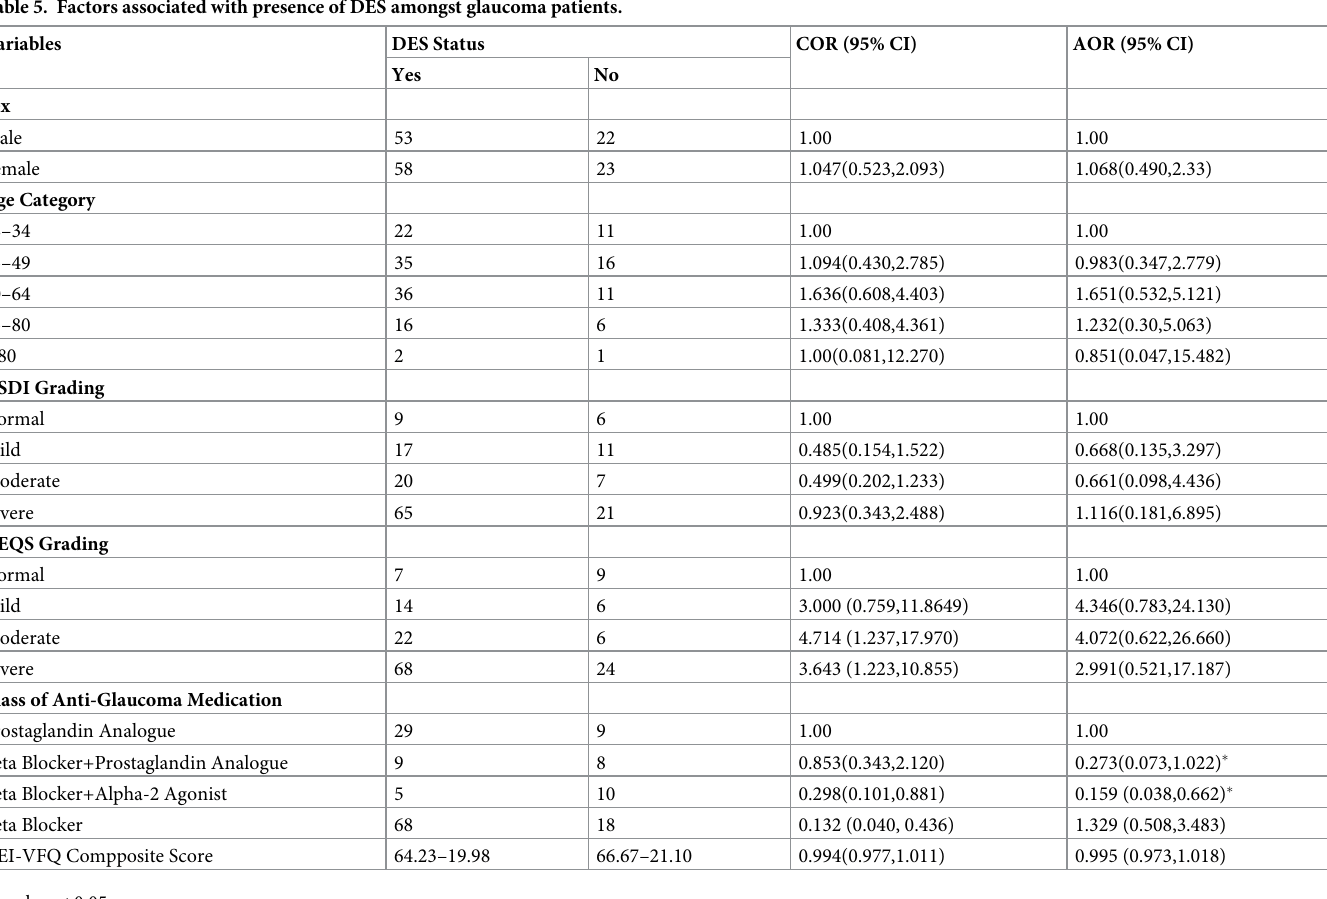
Table 5. Factors associated with presence of DES amongst glaucoma